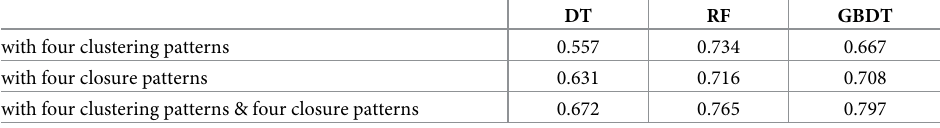
Table 2. Leave-one-out cross-validation accuracy in classifying network types. Three sets of network features (rows) are tested in three tree-based classifiers